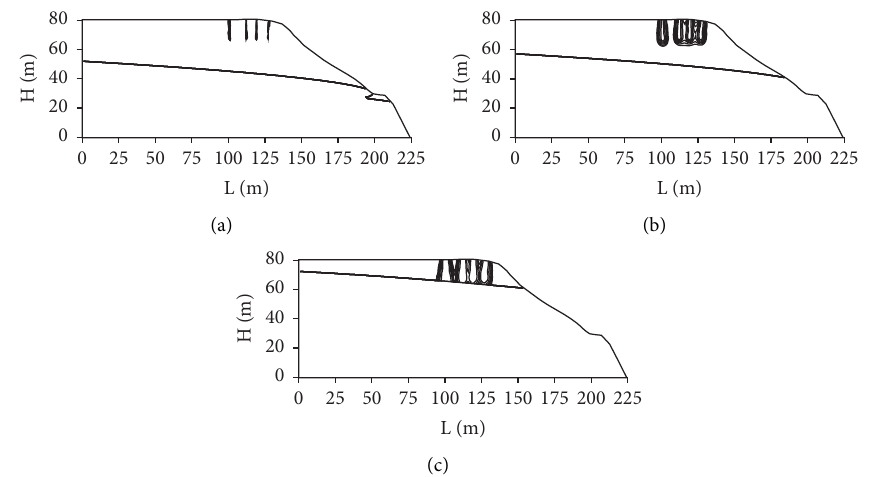
Figure 16: Distribution curve of matric suction (kPa) in the slope of different number of fissures (a), (b), and (c) matric suction at 0kPa, 50kPa, and